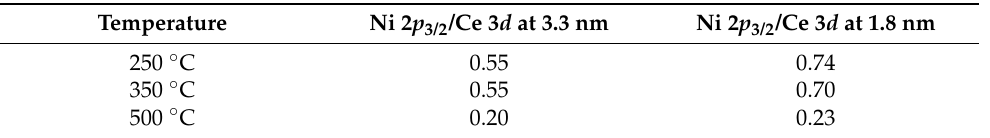
Table 3. Ni 2 p 3/2 /Ce 3 d ratio estimated at different depths for the 5Ni-CeO 2 NCs catalyst sample subjected to a reduction treatment in 1 mbar H 2 at increasing temperatures.